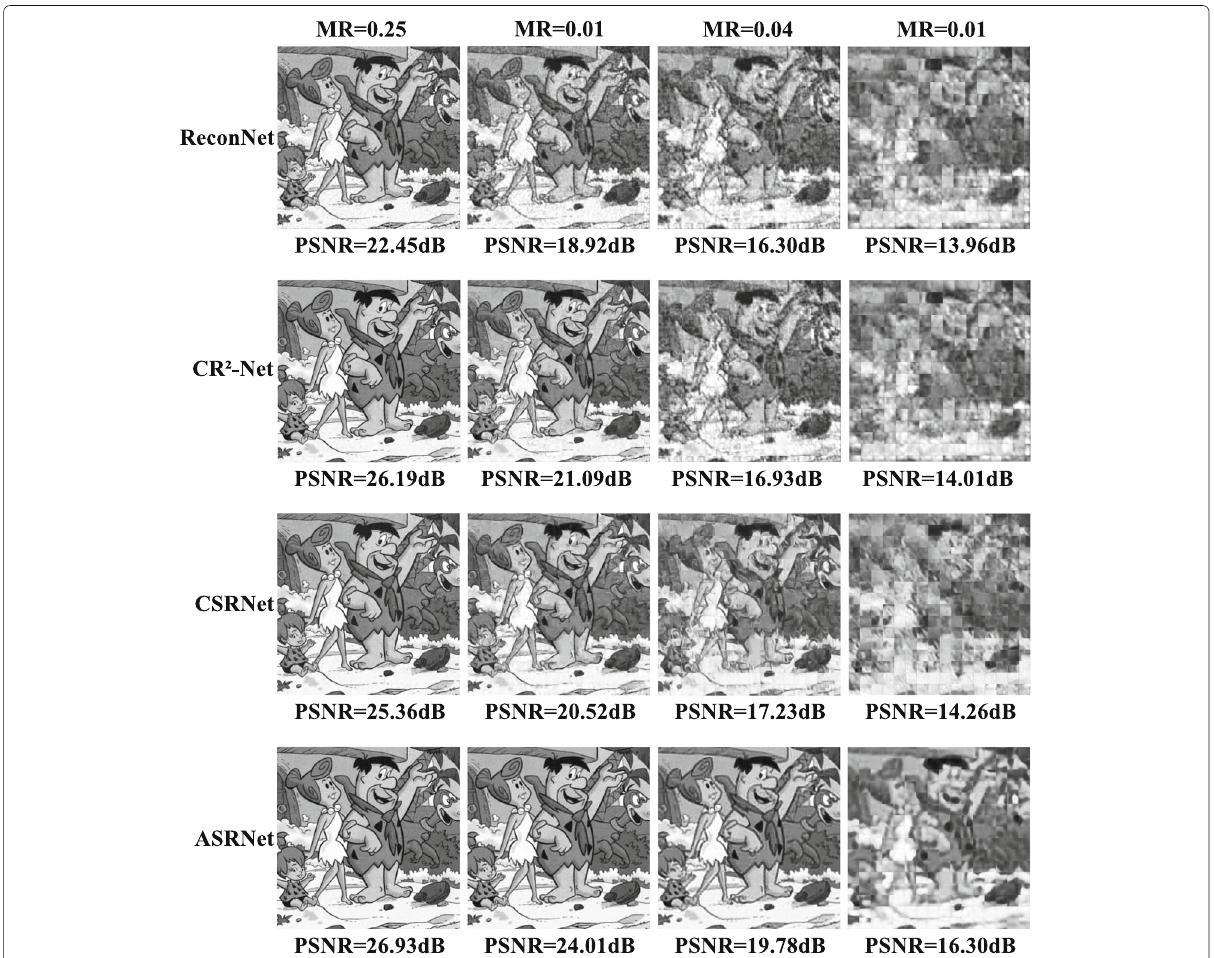
Fig. 15 The reconstruction results of Flinstones at the measurement rate of 0.25, 0.1, 0.04, and 0.01 without